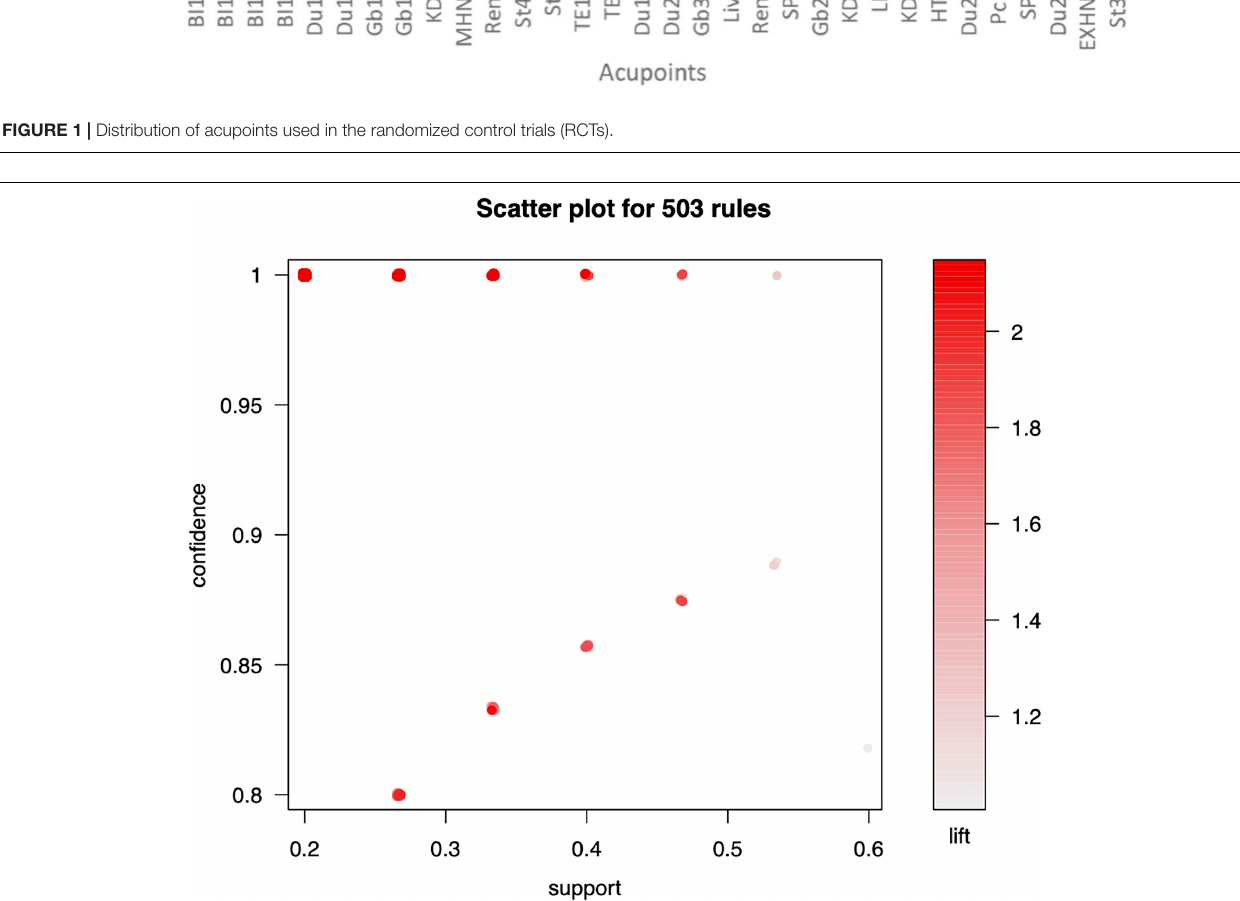
FIGURE 2 | Scatter plot for 503 rules.